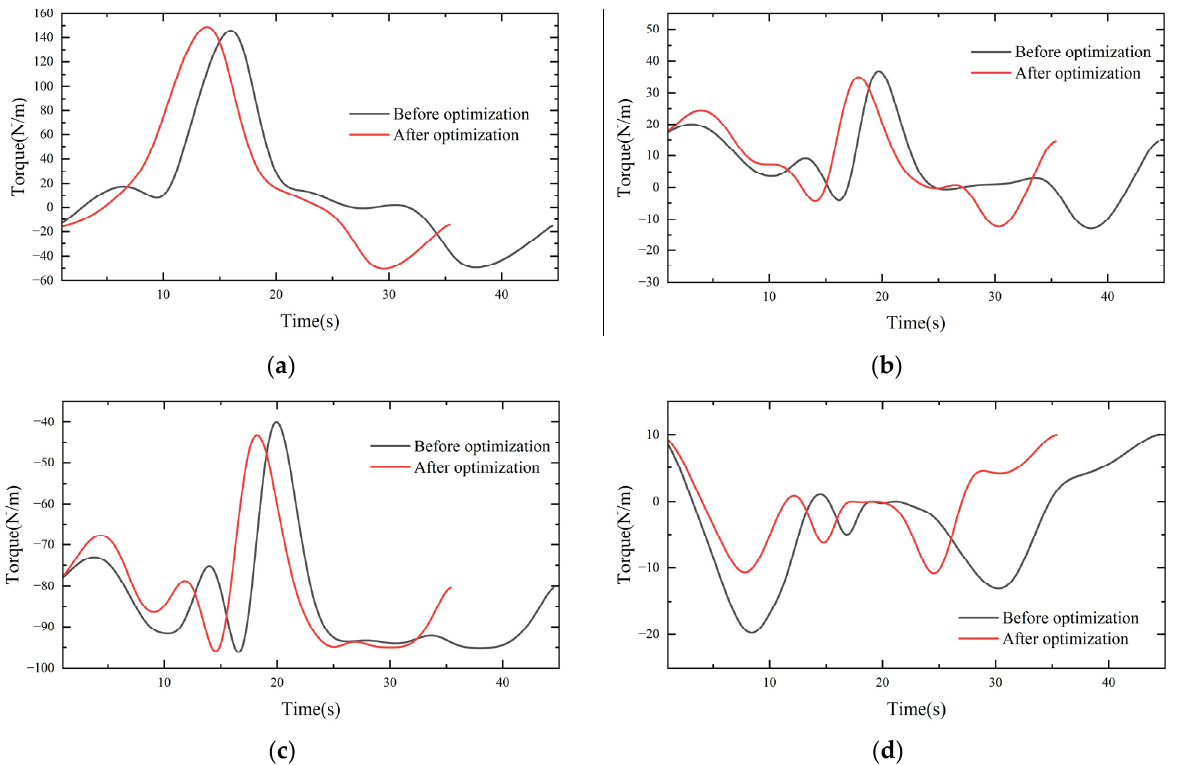
Figure 10. Comparison of joint torque curves: ( a ) joint two; ( b ) joint three; ( c ) joint four; ( d ) joint five.